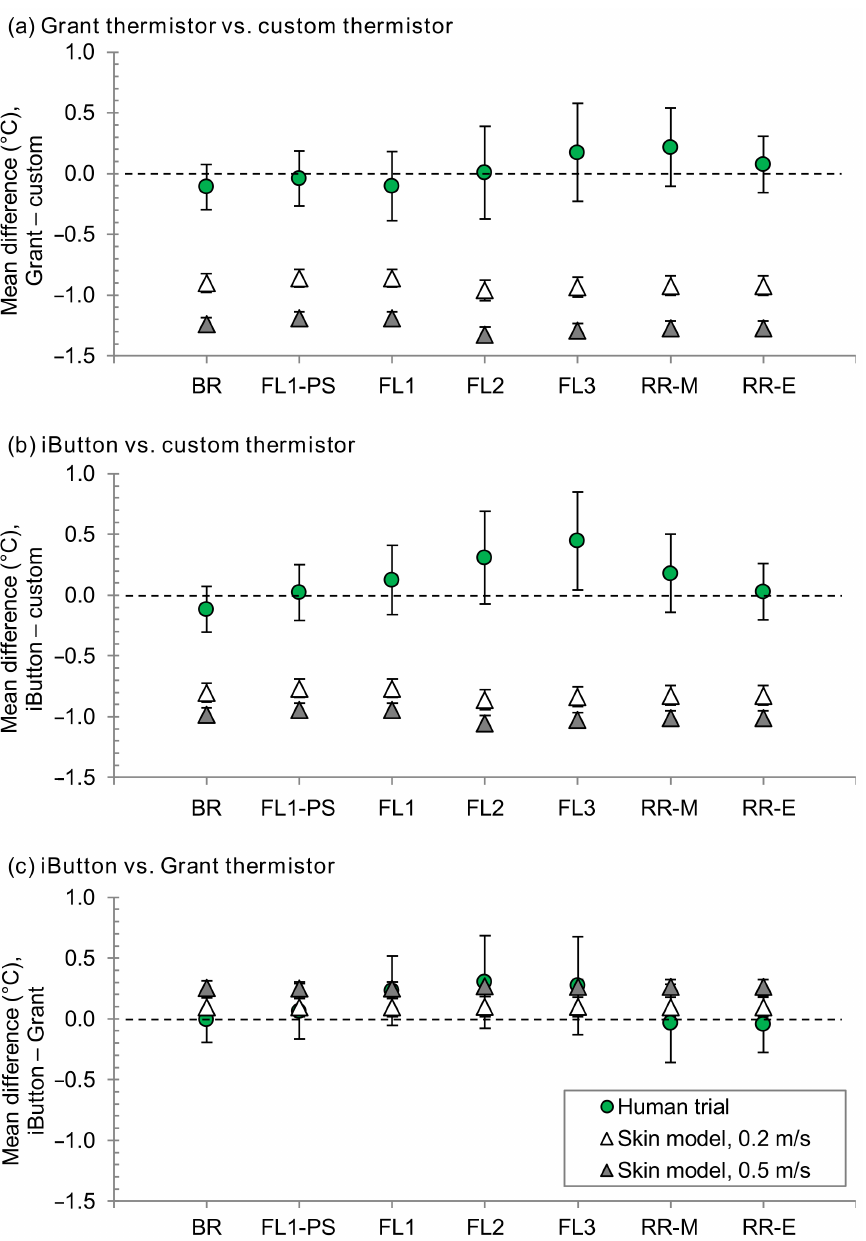
Figure 5. Mean differences between skin temperature sensors ( a – c ) during the human trial (weighted- mean skin temperature; n = 14) and skin model experiments (individual sensor temperature; n = 5 for each air velocity condition). Error bars indicate 95% confidence intervals. Negative differences indicate the first sensor listed being cooler than the second sensor listed. BR, end of baseline rest; FL1-PS, fixed-load cycling 1 pre-sweating; FL1–FL3, end of fixed-load cycling 1–3; RR-M, middle of recovery rest; RR-E, end of recovery